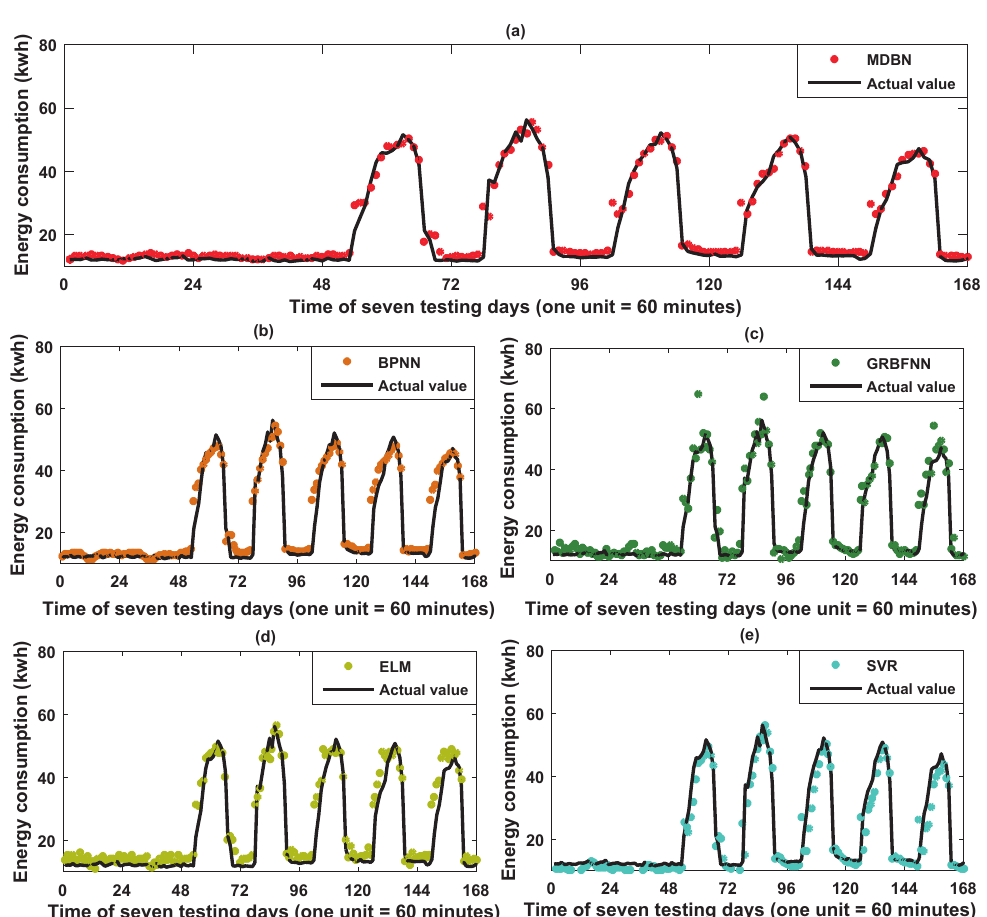
Figure 12. Parts of the prediction results of the five predictors constructed by utilizing the energy-consuming pattern: ( a ) hybrid DBN model; ( b ) BPNN; ( c ) GRBFNN; ( d ) ELM; and ( e )